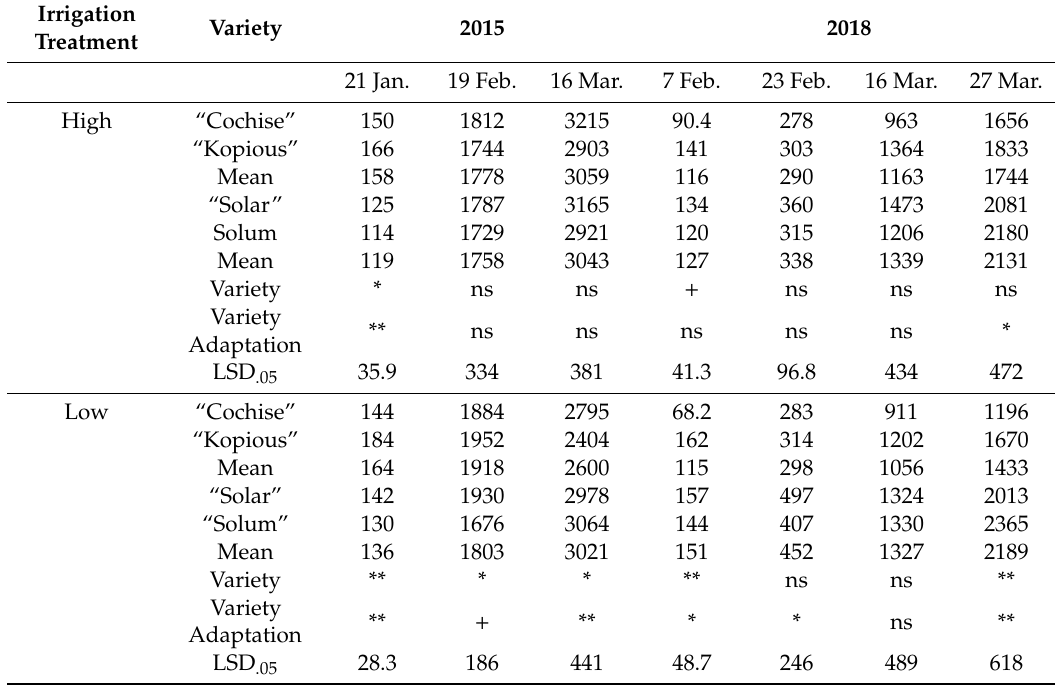
Table 4. E ff ect of irrigation treatment on biomass yield (g m − 2 ) of barley for trials conducted in Tucson in 2015 and